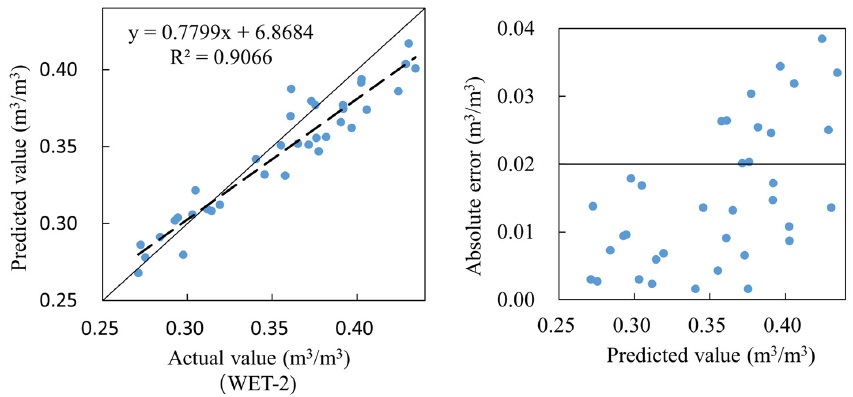
Figure 22. Field accuracy veri fi cation of sensors.